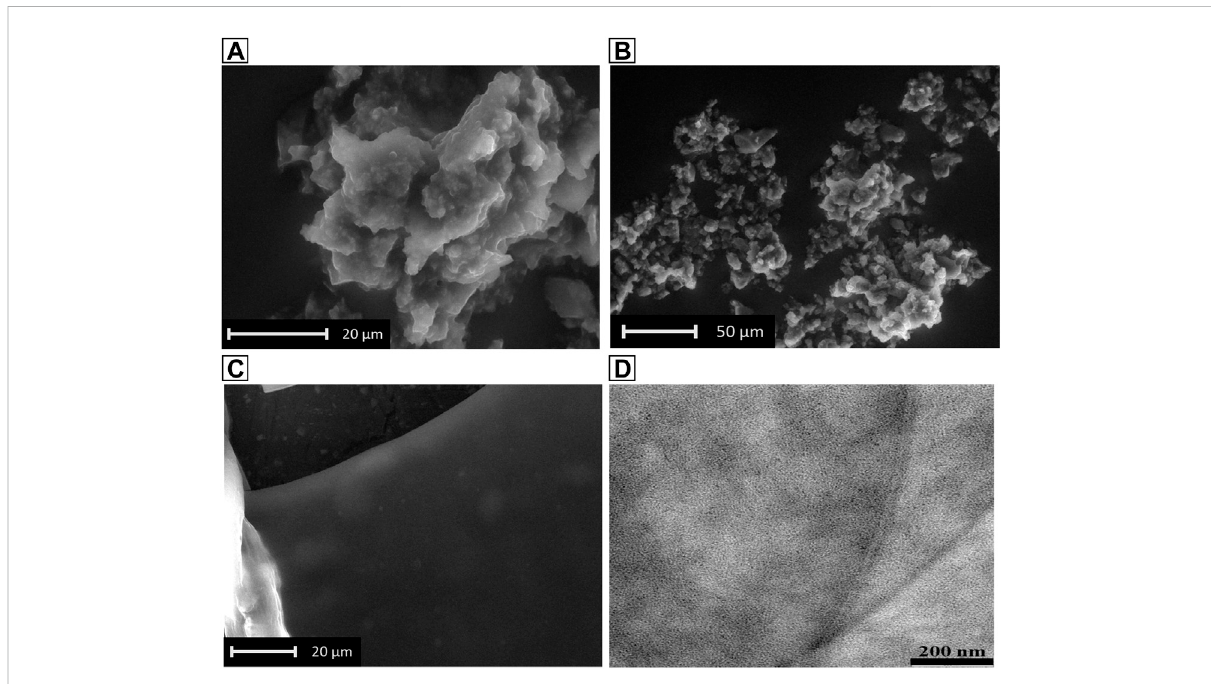
FIGURE 6 SEM images of the hydrogel in dry form (A) , and in wet form (B,C) . (D) : TEM image of the 2 mM hydrogel in dry